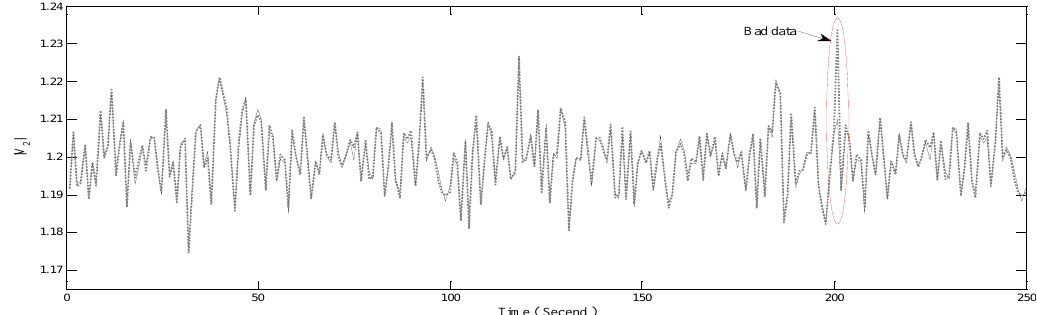
Figure 5. Falsified received measurement data of bus 2 with outlier.